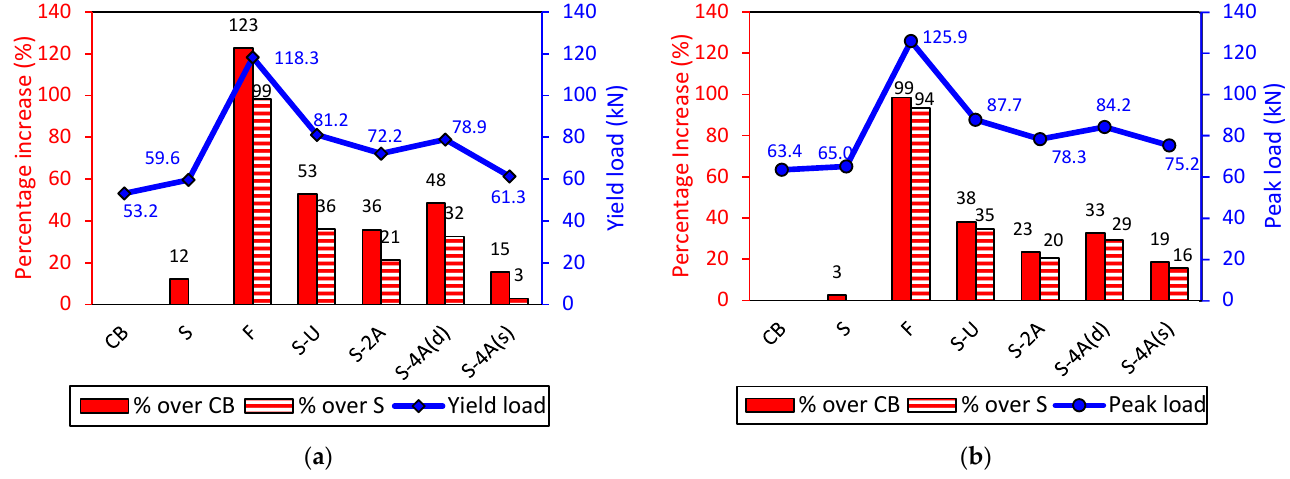
Figure 7. Flexural performance of the tested specimens: ( a ) Yield load; ( b ) Peak